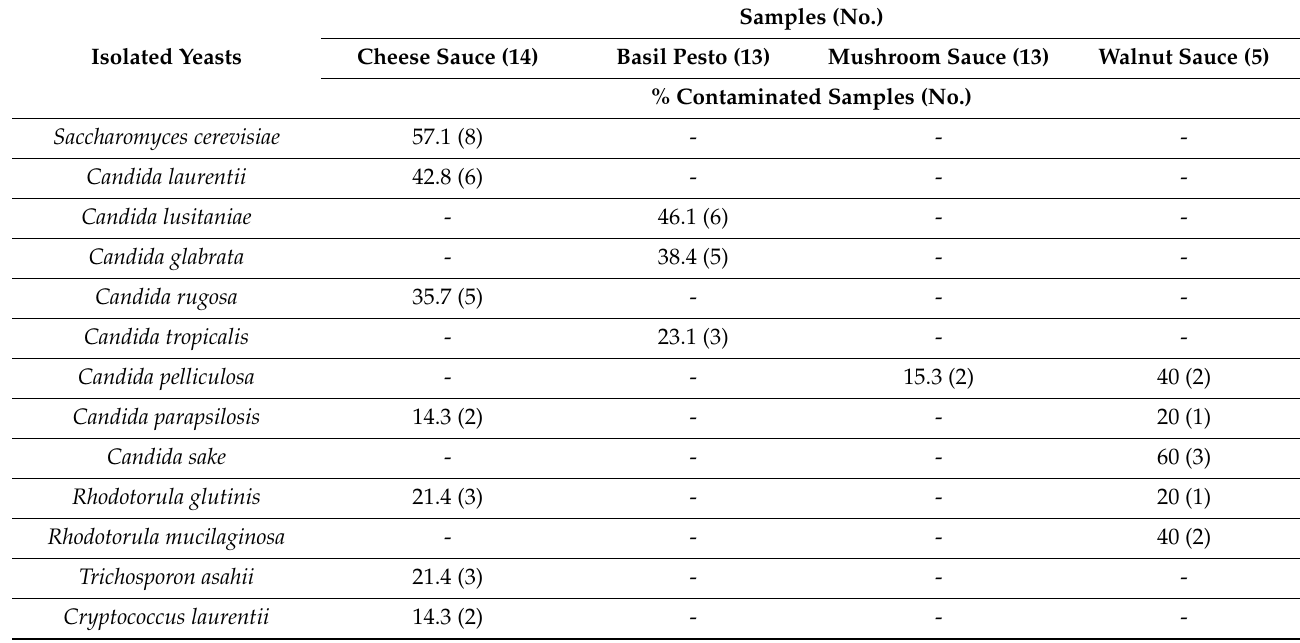
Table 2. Yeast species isolated in cheese sauce, basil pesto, mushroom sauce and walnut sauce